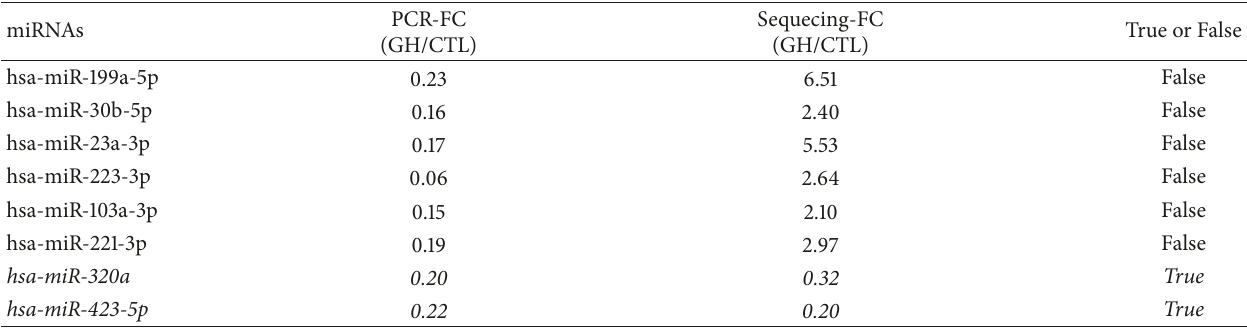
Table 1: Eight miRNAs differently expressed in exosome sequencing data and miRSCan PanelChipTM qPCR data. PCR-FC Sequecing-FC miRNAs True or False (GH/CTL) (GH/CTL) hsa-miR-199a-5p 0.23 6.51 False hsa-miR-30b-5p 0.16 2.40 False hsa-miR-23a-3p 0.17 5.53 False hsa-miR-223-3p 0.06 2.64 False hsa-miR-103a-3p 0.15 2.10 False hsa-miR-221-3p 0.19 2.97 False hsa-miR-320a 0.20 0.32 True hsa-miR-423-5p 0.22 0.20 True True: miRNAs expressed both higher or lower in exosome sequencing data and miRSCan PanelChipTM qPCR data in somatotroph adenoma. False: miRNAs expressed both higher in exosome sequencing data and lower in miRSCan PanelChipTM qPCR data or expressed both lower in exosome sequencing data and higher in miRSCan PanelChipTM